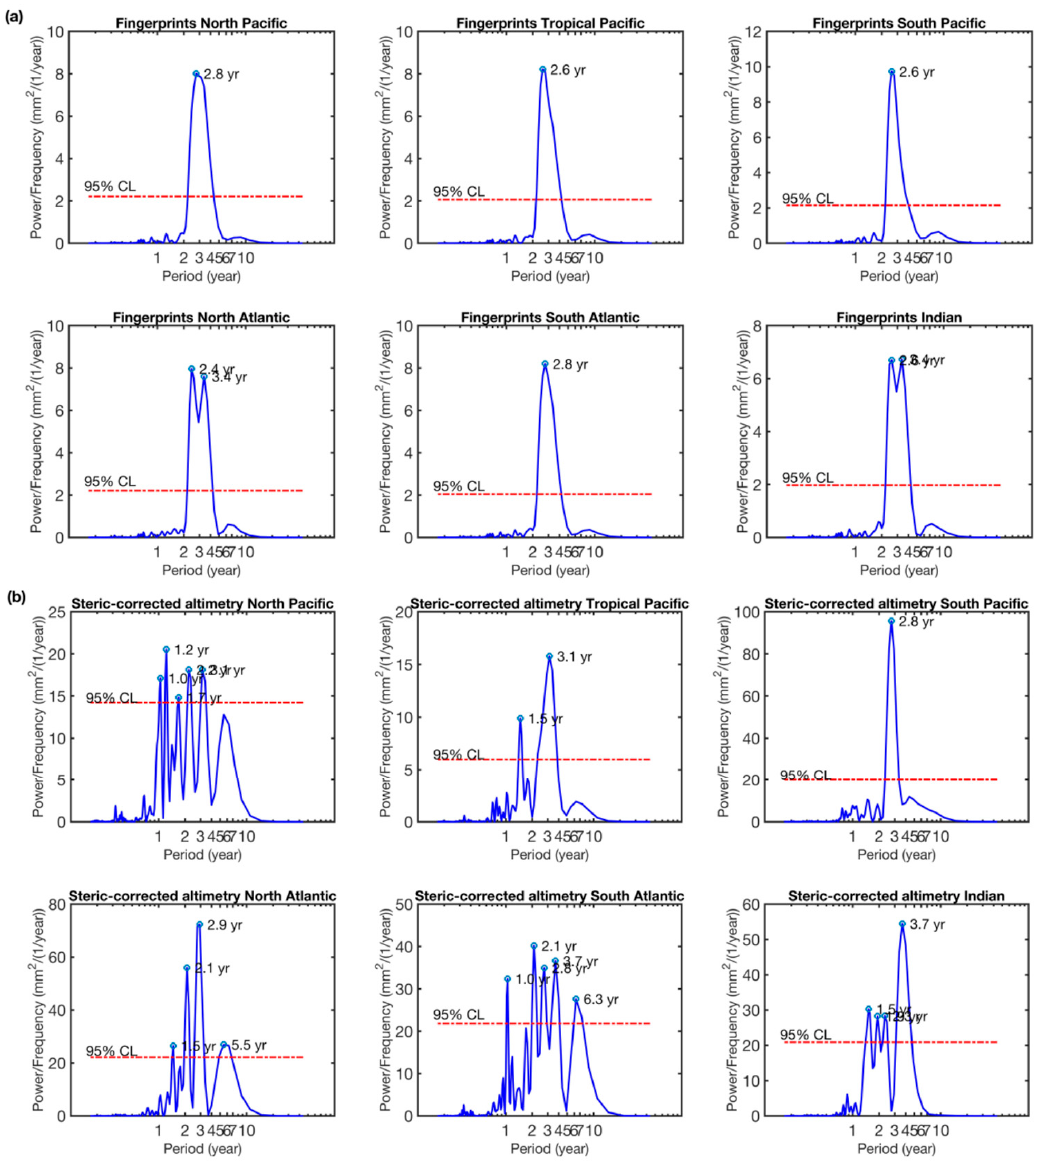
Figure 8. Periodograms of the regionally averaged absolute sea-level fingerprints ( a ) and steric-corrected altimetry-based sea-level ( b ), quadratically detrended time series, for January 2005–December 2015 and with a 6-month smoothing applied to the basin averages. The x-axes are in logarithmic scale. The horizontal red line represents the 95% confidence level (noted CL) of the peaks.